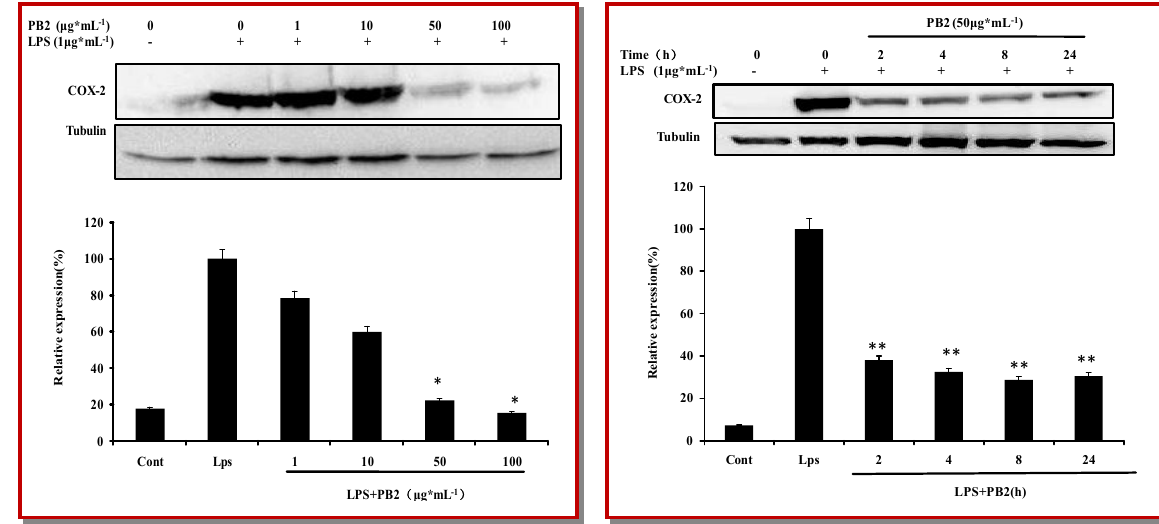
Figure 3: Effect of PB2 with different concentrations on COX-2 expression in LPS-induced RAW 264.7 macrophage cells. *Significant difference: p< 0.05 as compared to the LPS-treated group